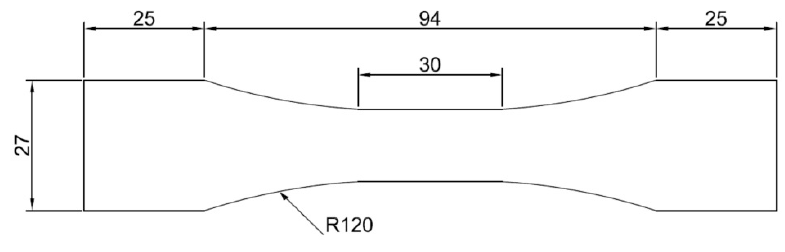
Figure 3. Sample geometry and dimensions expressed in mm [37].